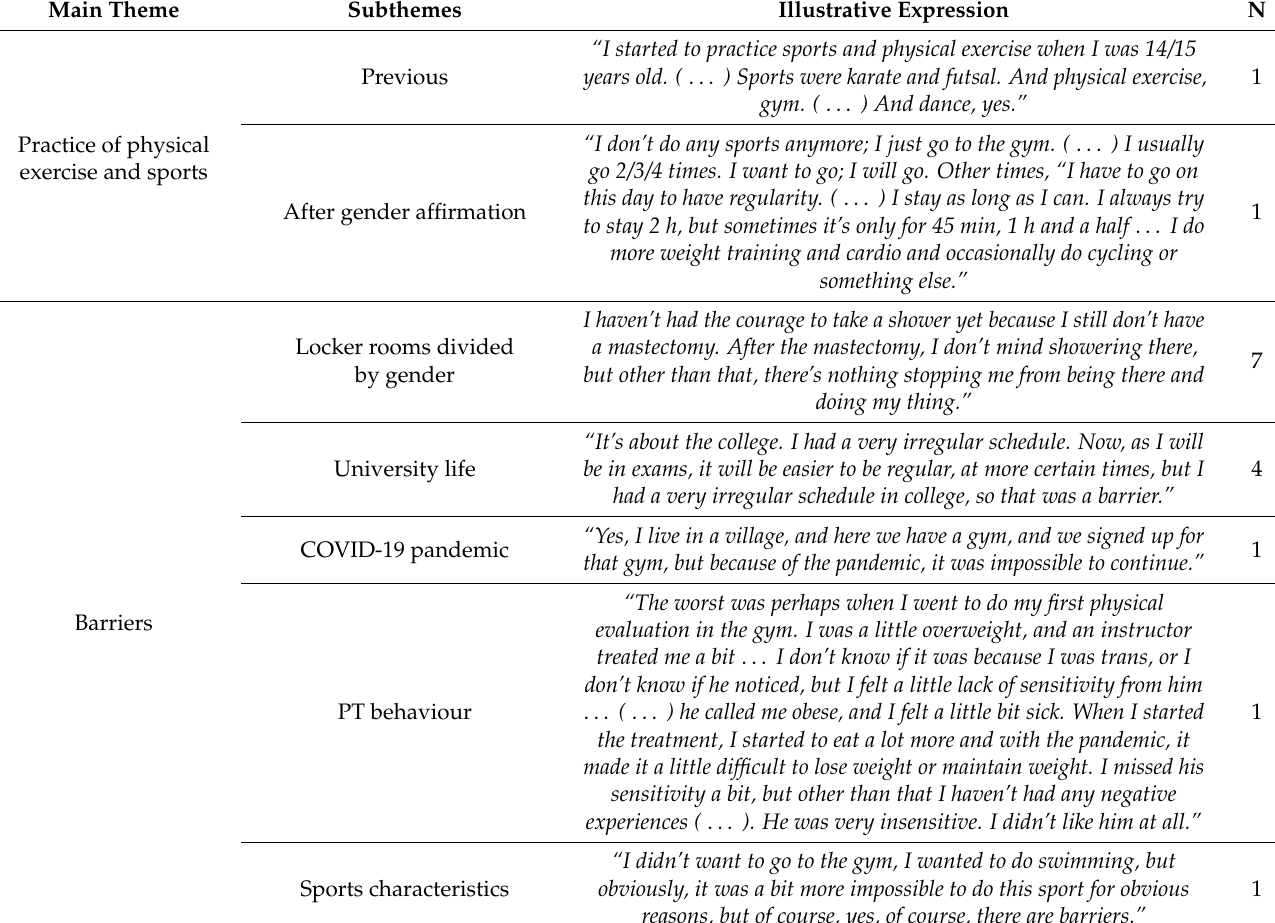
Table 2. Qualitative analysis of the